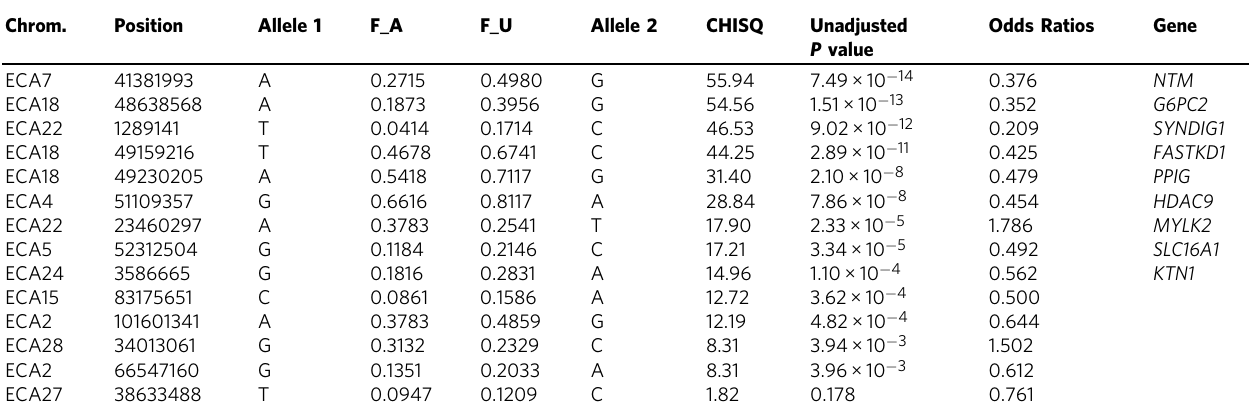
Table 4 SNPs signi fi cantly associated with the racing phenotype among global breeds.